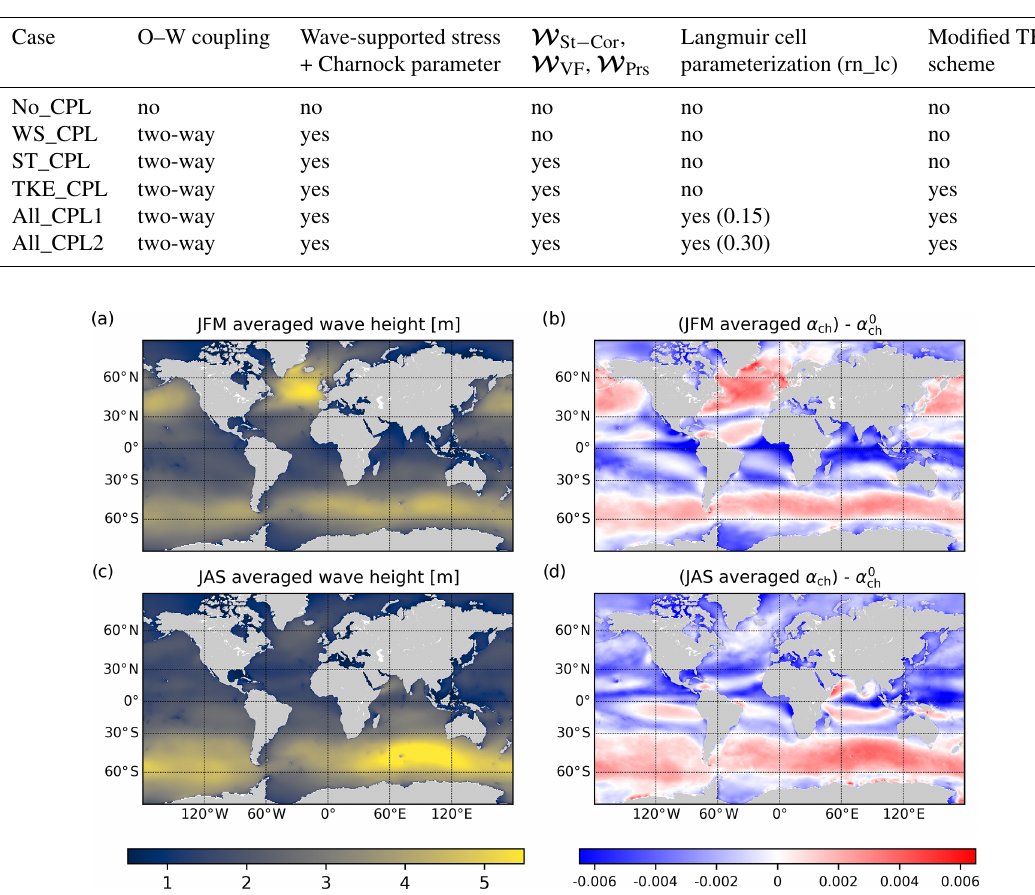
Figure 3. (a, c) Seasonal averages of significant wave height (in meters) for January–February–March (JFM, panel a ) and July–August– September (JAS, panel c ). (b, d) Seasonal average of the difference between the Charnock parameter as computed by the wave model and = 0 . 018 for JFM (b) and JAS (d) the default value α 0 ch